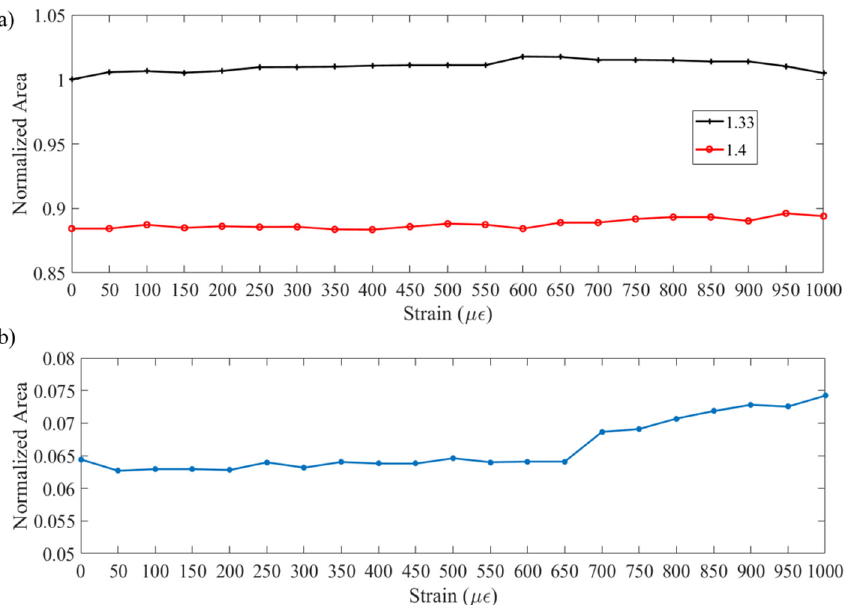
Figure 5. ( a ) Trends of the normalized areas for 1.33 and 1.40 RIs and ( b ) 1.46, with the increasing of strain on the TFBG sensor.